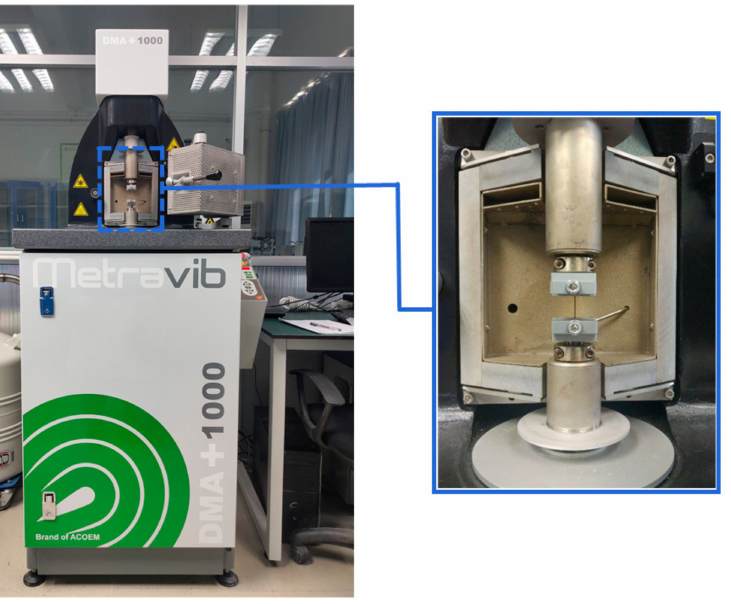
Figure 2. DMA + 1000 and test